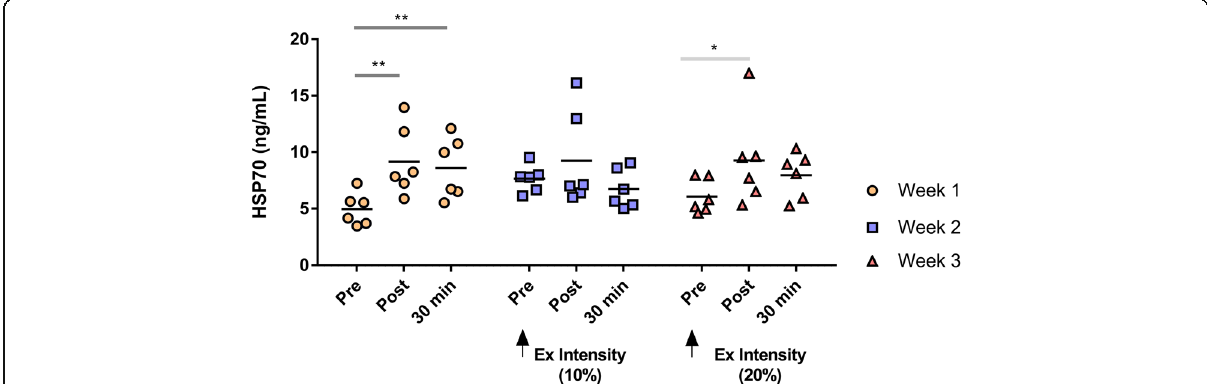
Fig. 5 Plasma [HSP70] during 3 weeks of exercise training ( N = 6). A significant main effect of time was observed ( P = 0.0003). Post hoc Tukey ’ s test was used to compare mean HSP70 between timepoints within each week. * P < 0.05 and ** P <